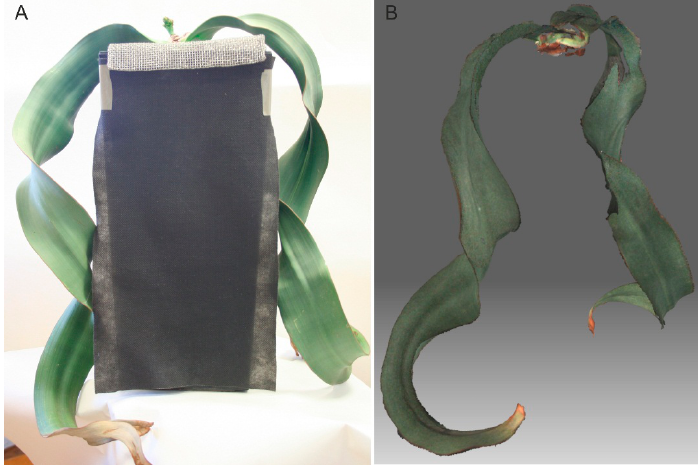
Figure 3. Welwitschia mirabilis : ( A ) Natural picture; ( B ) Computer model.